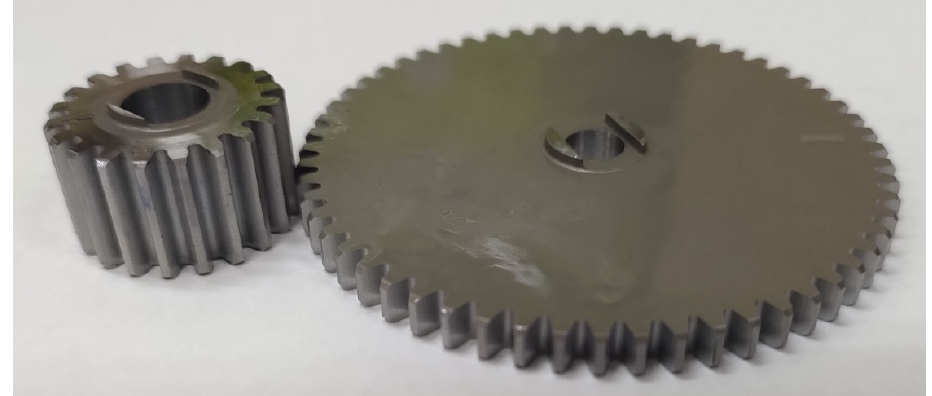
Figure 13. Manufactured test spur gear set.